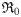
Sensitivity of parameter estimations to R0.Local sensitivity of R0 based on sensitivity index (left) and the partial rank correlation coefficients for global sensitivity of R0 based on Latin Hypercube sampling (right).